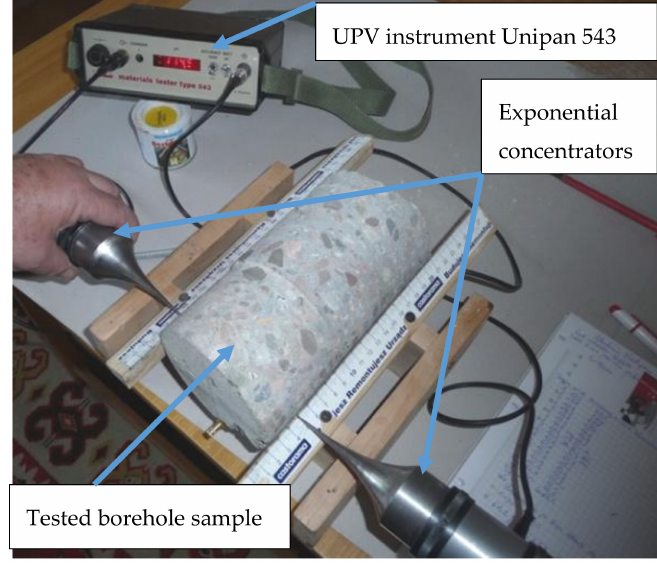
Figure 5. Borehole No. 1 during ultrasound tests.